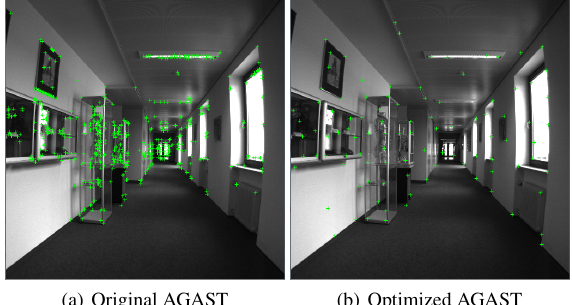
Figure 5: Comparison of the AGAST feature extractors